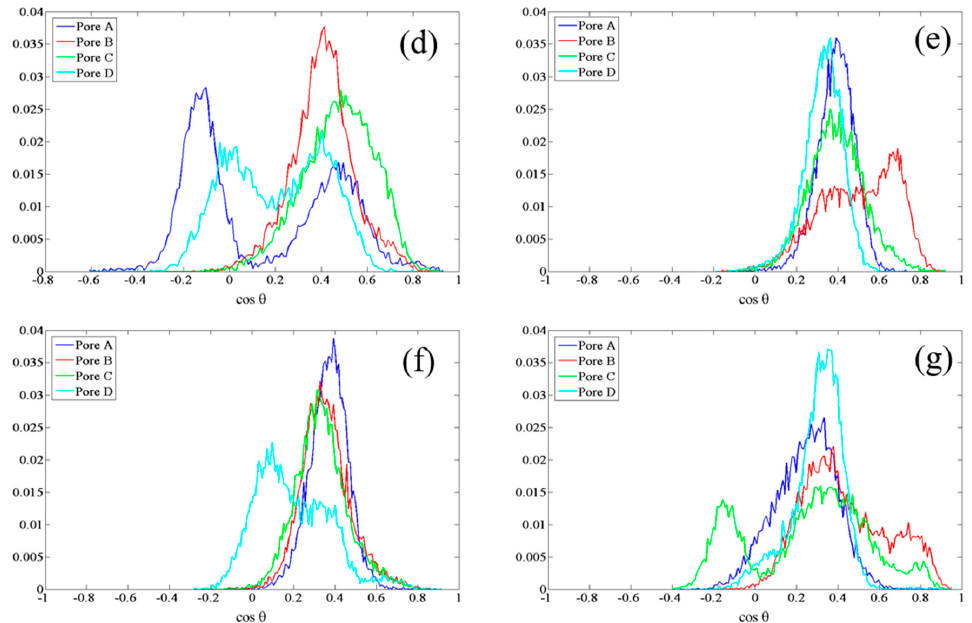
Figure 3. Normalized probability distribution of cos θ in all four pores, for SER-211 in the “upper” gate (see Figure 2) under: ( a ) zero-field; ( b – d ) static fields of 0.02, 0.035 and 0.065 V/Å, respectively, along the − y -axis; and ( e – g ) static fields of 0.02, 0.035 and 0.065 V/Å, respectively, along the + y -axis.